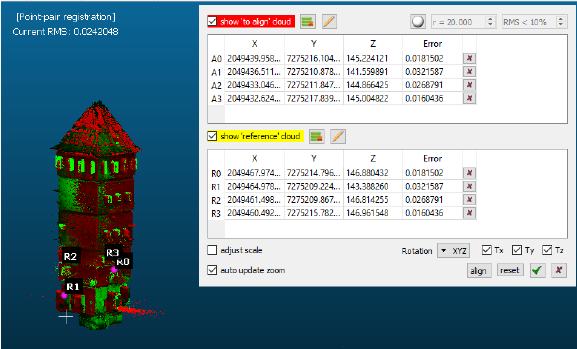
Figure 2. Rough alignment of MMS and reference point clouds in CloudCompare